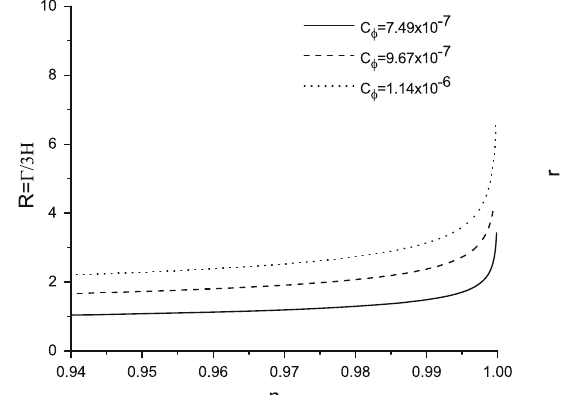
Fig. 3 Plots of R = (cid:2)/ 3 H as a function of the scalar spectral index n s ( left ) and the tensor-to-scalar r as function of the scalar spectral index n s ( right ). For both plots we have considered three different val- ues of the parameter C φ for the case a = 0, i.e., (cid:2) ∝ φ , assuming the model evolves according to the strong dissipative regime. In both pan-